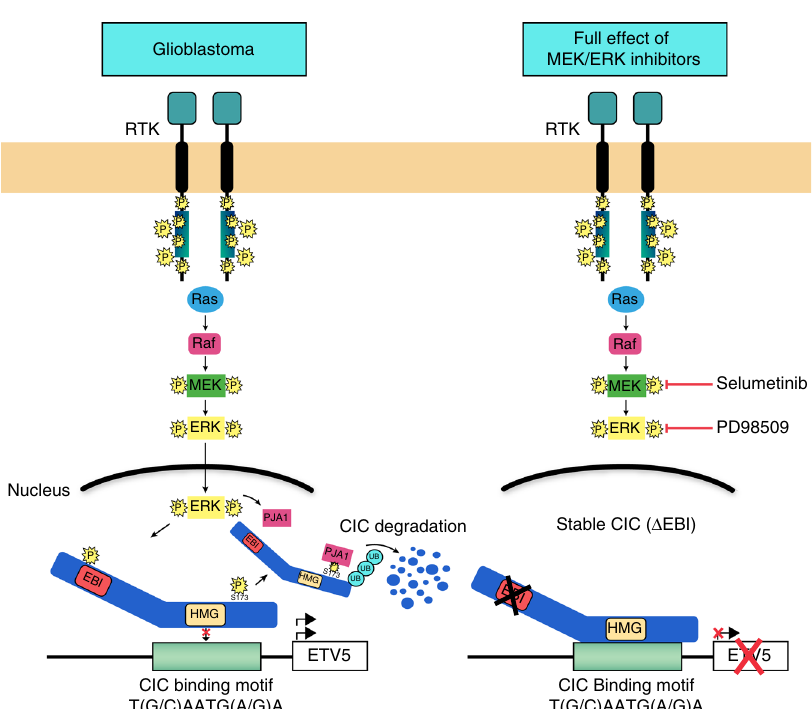
Fig. 7 A model depicting CIC regulation in GBM and effect of the loss of CIC ’ s ERK-binding domain on sensitivity to ERK